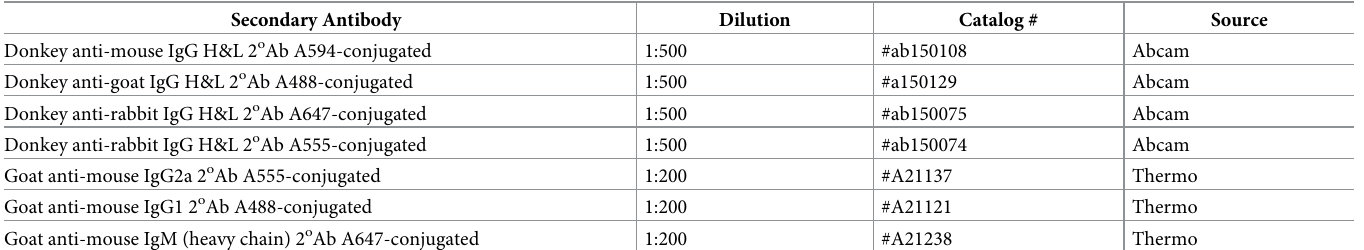
Table 2. Secondary antibodies used in Immunofluorescence